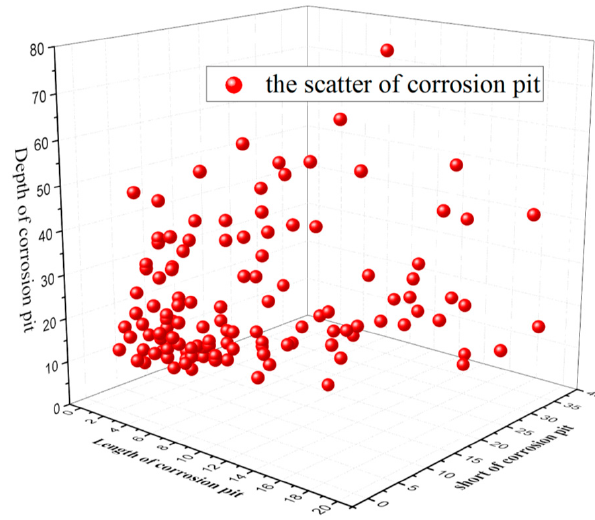
Figure 6. The size of the corrosion pit.